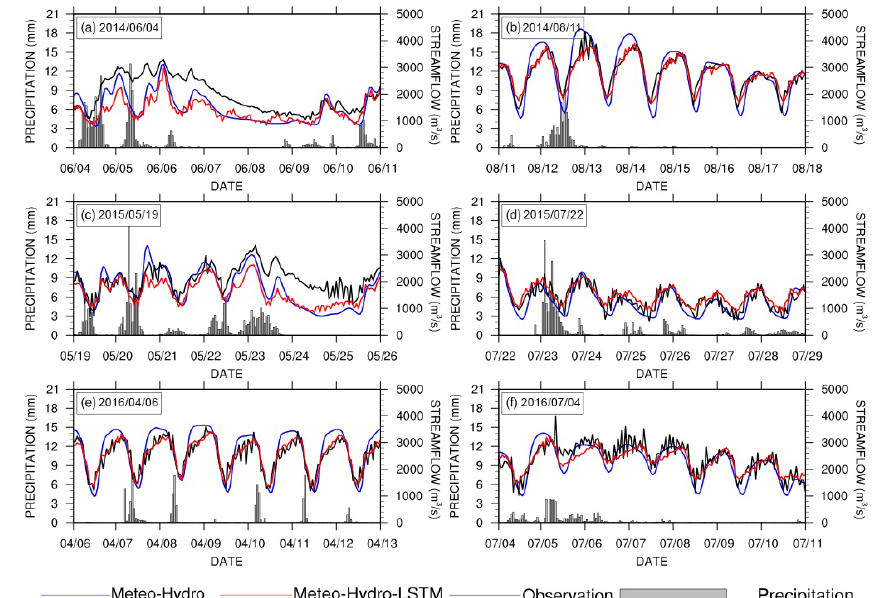
Figure 10. Evaluation of the forecast approaches for a few flooding events. The black lines are observed streamflow from the Yantan hydrological gauge, the blue lines are the Meteo-Hydro ensemble mean streamflow forecast and the red lines are the Meteo-Hydro-LSTM forecast streamflow using the Meteo-Hydro ensemble mean forecast with LSTM. The gray bars represent hourly precipitation averaged over the basin. (Please note that dates are given in the following format in this figure: